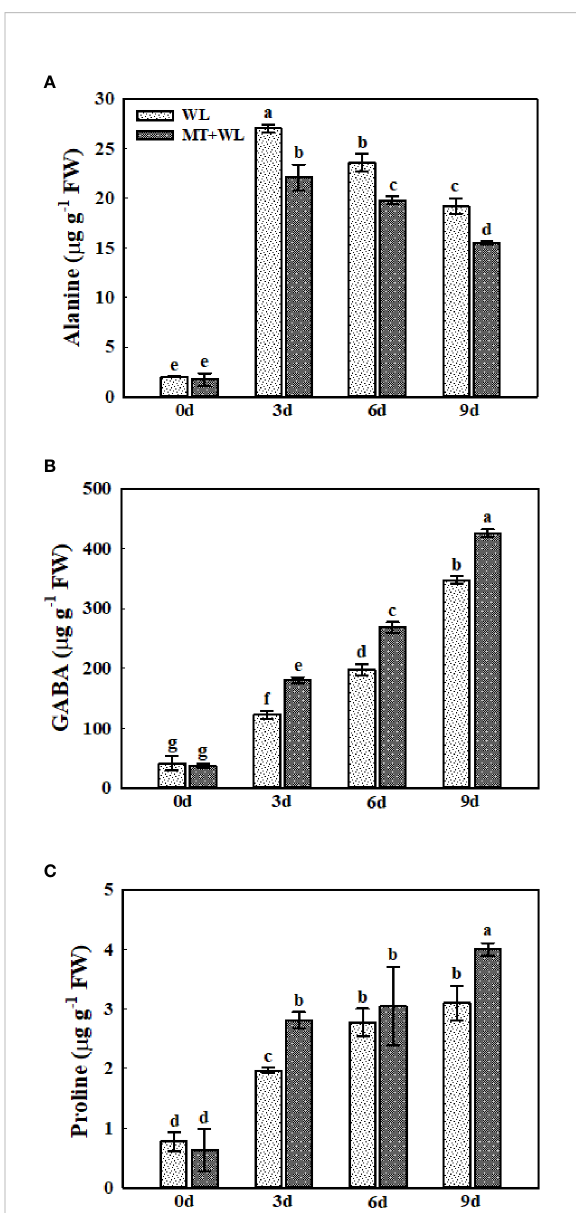
FIGURE 5 The concentrations of Ala, GABA, and Pro in the roots of kiwifruit plants under waterlogging stress, as measured by LC-MS. (A) Ala. (B) GABA. (C) Pro. Data are shown as the means of three replicates with SEs. Different letters indicate signi fi cant differences between treatments, according to one-way ANOVA and Tukey ’ s multiple range test (P < 0.05).